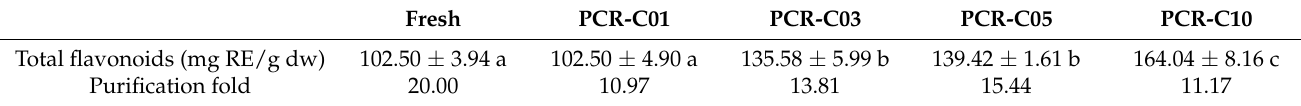
Table 3. Purification fold and total flavonoids content in PCR-C samples after purification.